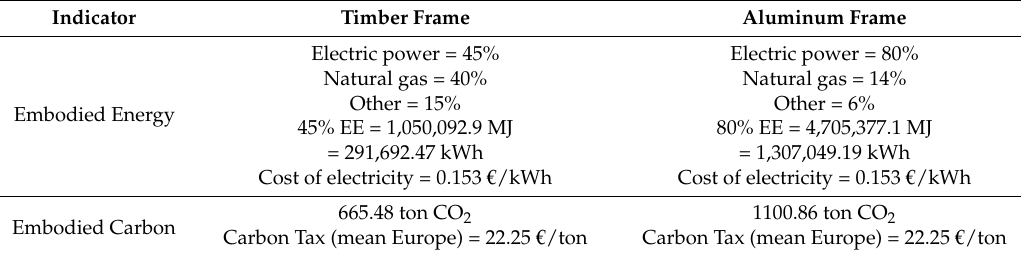
Table 7. Assumptions and values for Embodied Energy and Embodied